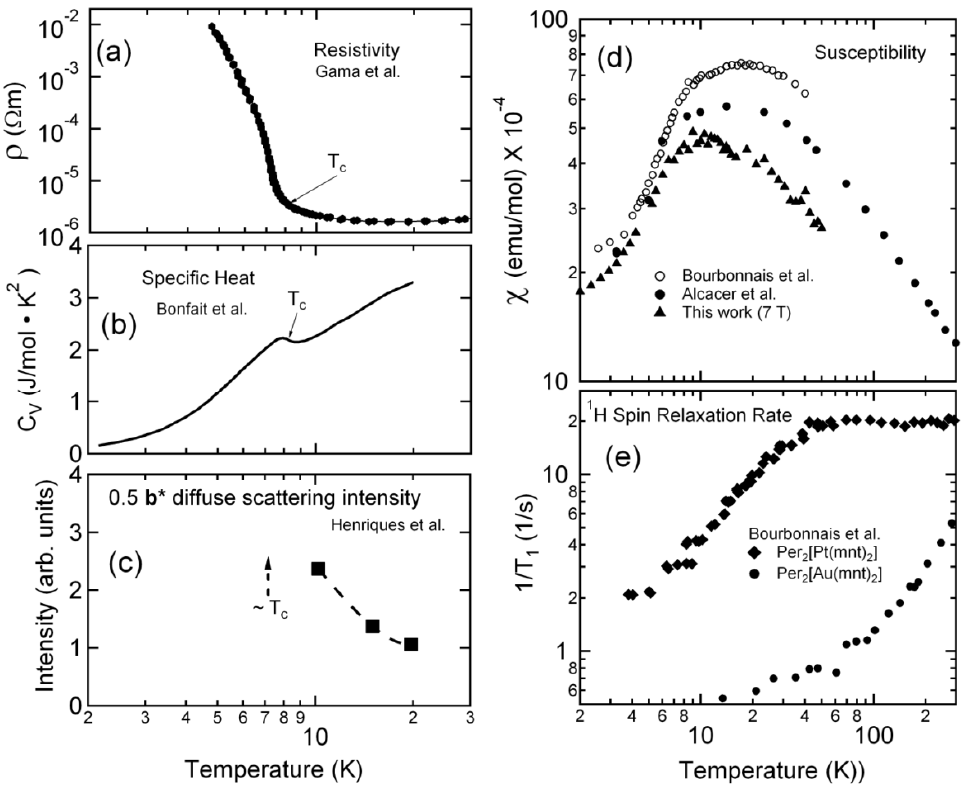
Figure 2. Selected temperature dependent physical properties of Per in vicinity of metal-insulator transition T heat showing a jump at magnetic transition due to Pt spins (data from Reference [6]); ( c ) X-ray scattering showing onset of the diffuse 0.5 b* peak approaching T Reference [11]); ( d ) Magnetic Susceptibility from three different studies (data from Reference [2,12] and this work); ( e ) Comparison of 1 H spin relaxation rates for M = Pt and M = Au materials (data from Reference